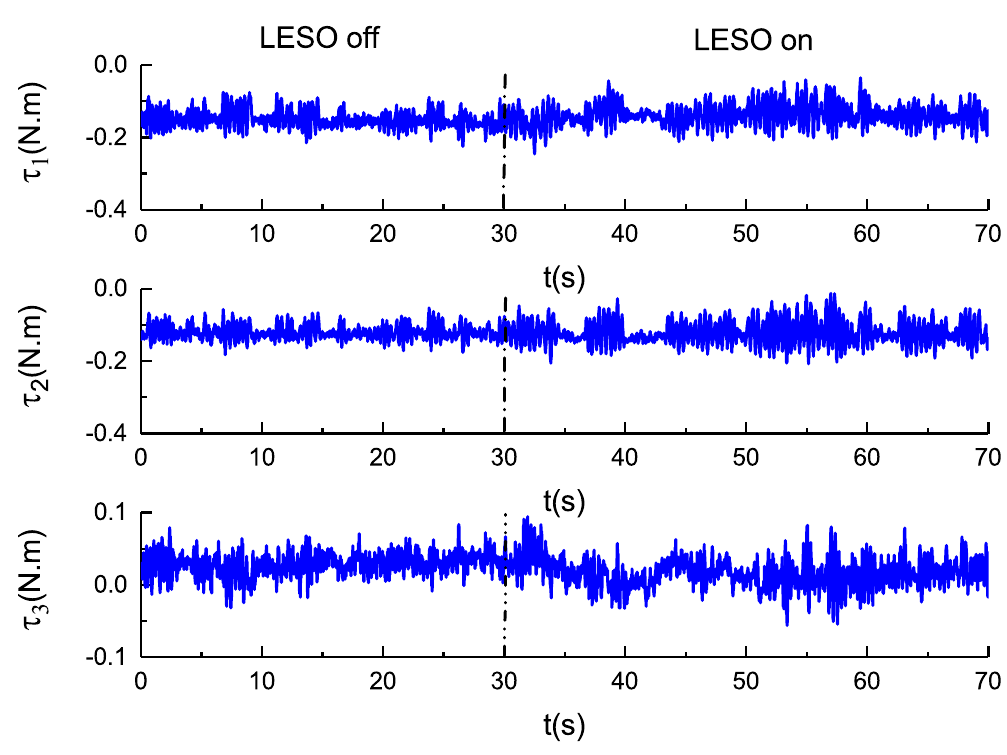
Figure 6. Control torque with the LESO off and on using attitude